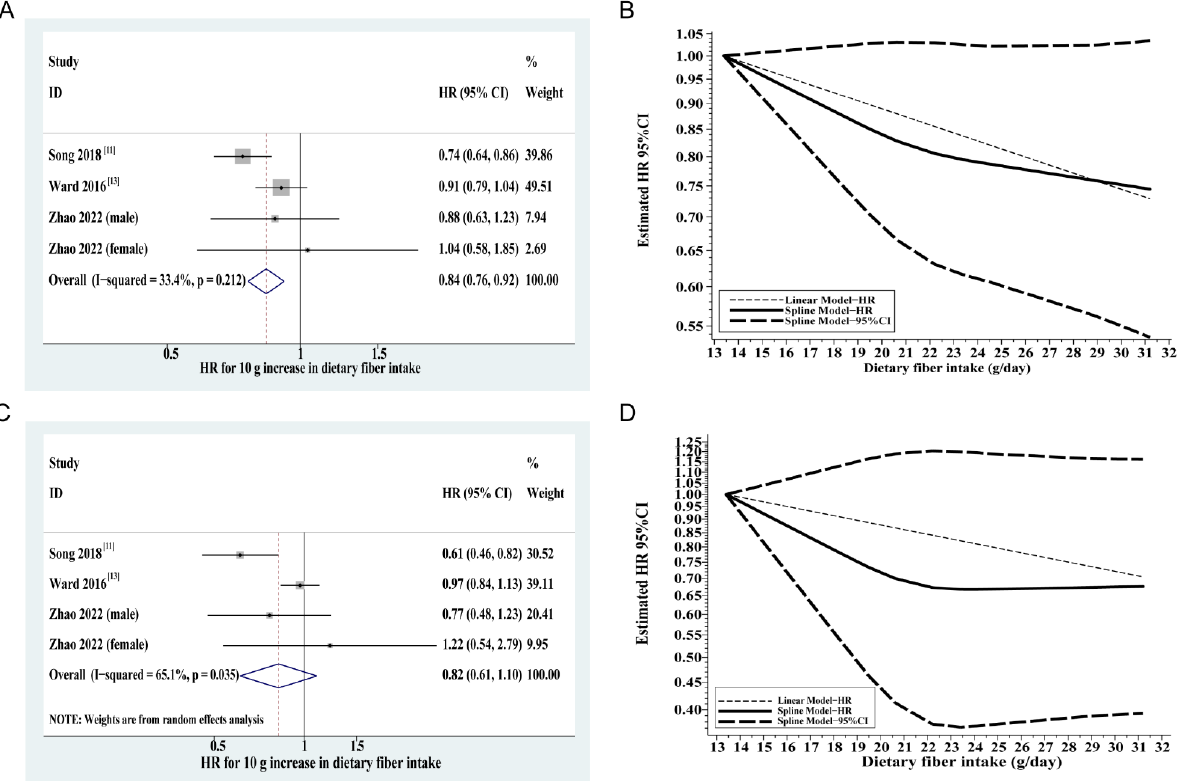
Figure 3. Linear and nonlinear dose–response meta-analyses of dietary fiber and mortality. ( A ) Linear dose–response meta-analyses per 10 g/day increase in dietary fiber intake for all-cause mortality; ( B ) Linear and nonlinear dose–response curve for all-cause mortality; ( C ) Linear dose–response meta-analyses per 10 g/day increase in dietary fiber intake for CRC-specific mortality; ( D ) Linear and nonlinear dose–response curve for CRC-specific mortality. Abbreviations: CRC, colorectal can- cer; HR, hazard ratio; CI, confidence interval.